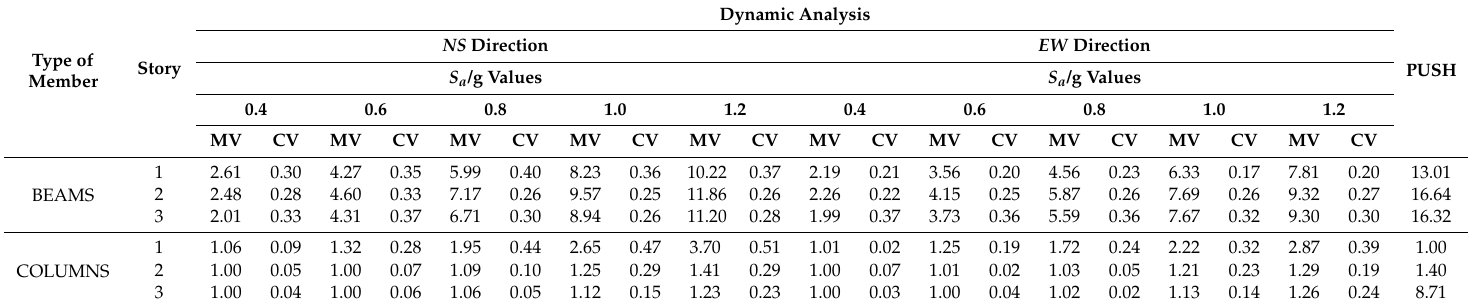
Table 3. Statistics for µ L φ , 3-level building.